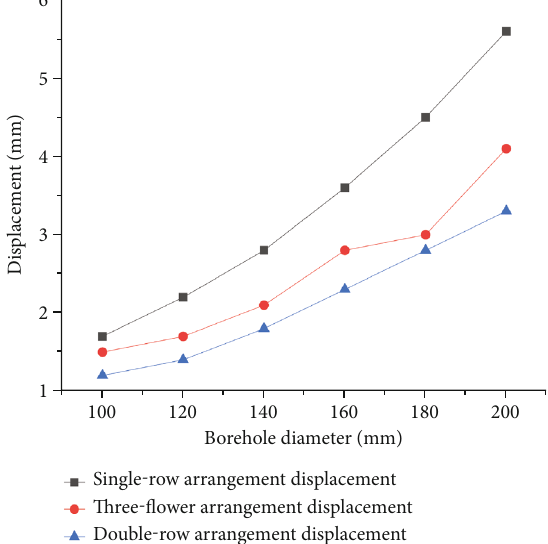
Figure 13: Displacement in boreholes of di ff erent diameter.